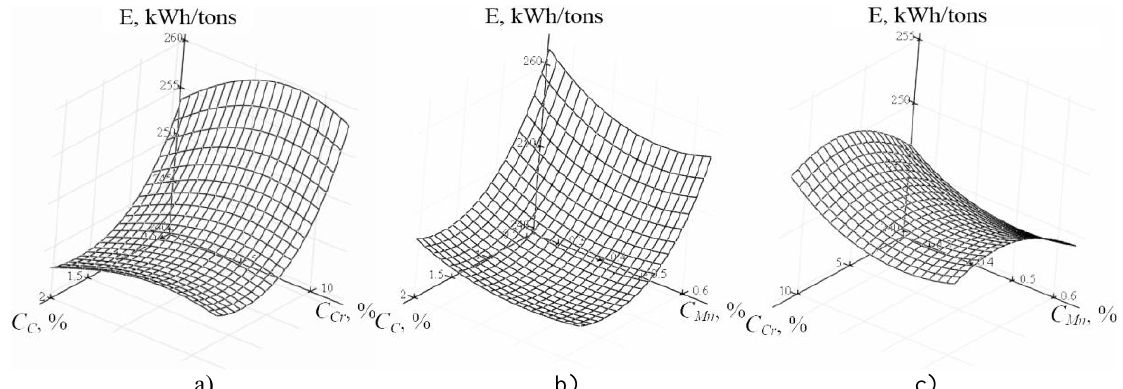
Fig. 2. Response surfaces of the objective function - energy consumption E of the process of dehydration of the hardened screw press of mixed solid household waste in the planes of the parameters of impact after its operation and wear on the way s = 56850 m (а) – E = f ( C C , C Cr ), (b) – E = f ( C C , C Mn ), (c) – E = f ( C Cr , C Mn